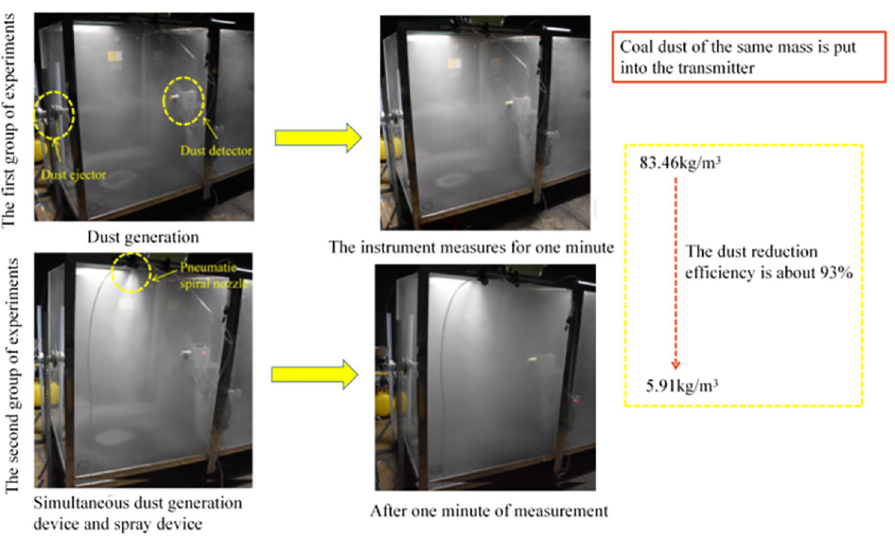
Fig 6. Experimental results of spray dustfall.